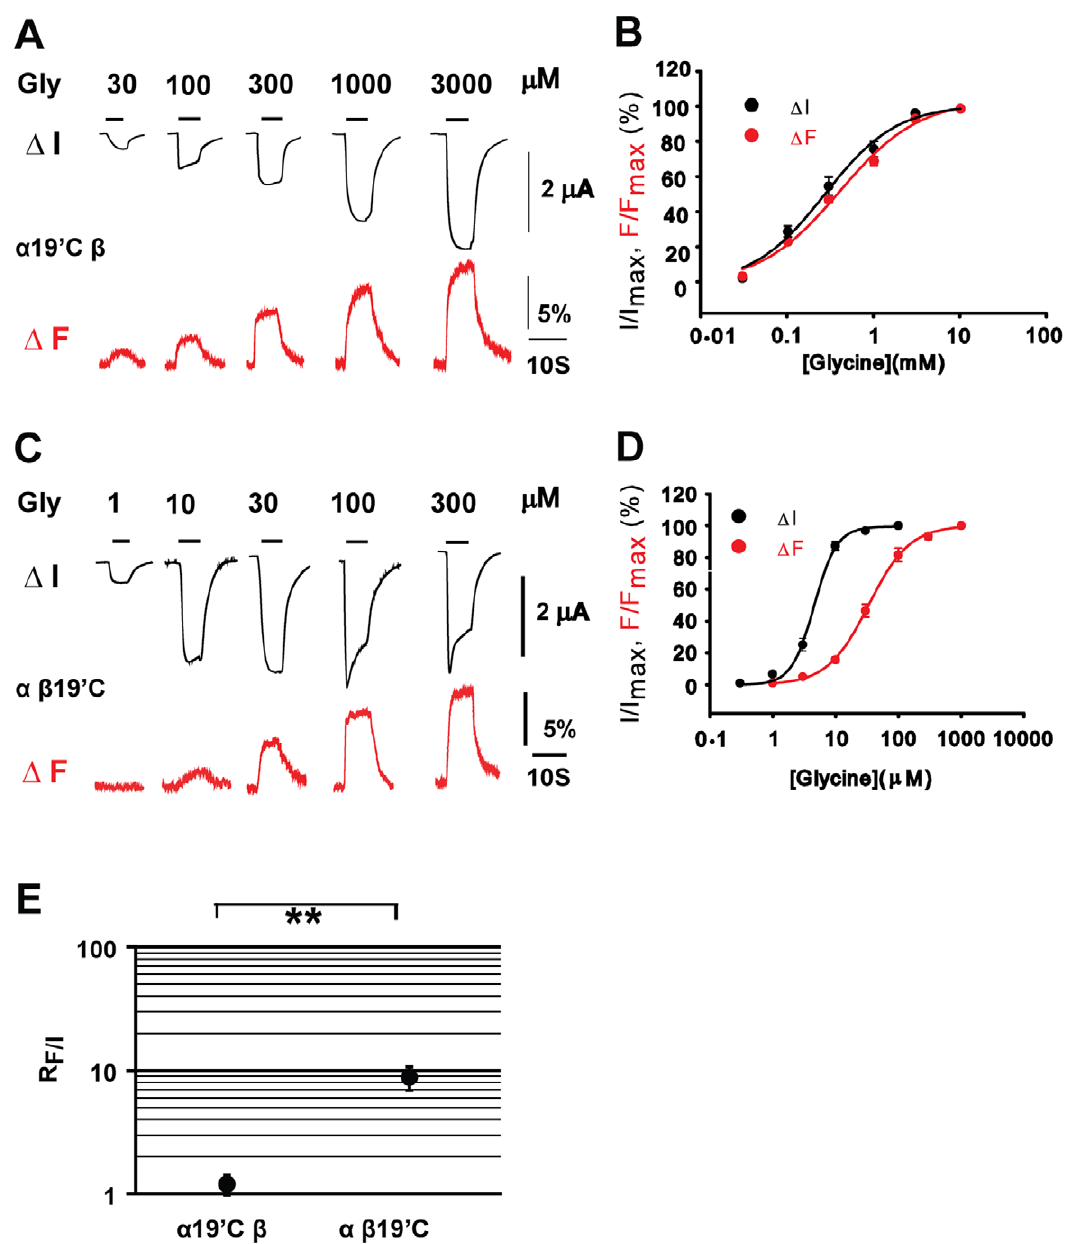
Figure 3. VCF of a 1 b GlyRs. Example current and fluorescence traces of the a 19 9 C b and a b 19 9 C GlyRs are shown in (A) and (C), respectively. Averaged normalized glycine concentration-response curves of current and fluorescence of the a 19 9 C b and a b 19 9 C GlyRs are shown in (B) and (D), respectively. The R F/I s (the EC 50 of fluorescence divided by the EC 50 of current) of the a 19 9 C b and a b 19 9 C GlyRs are plotted (E). ( ** p , 0.01 using the Student’s